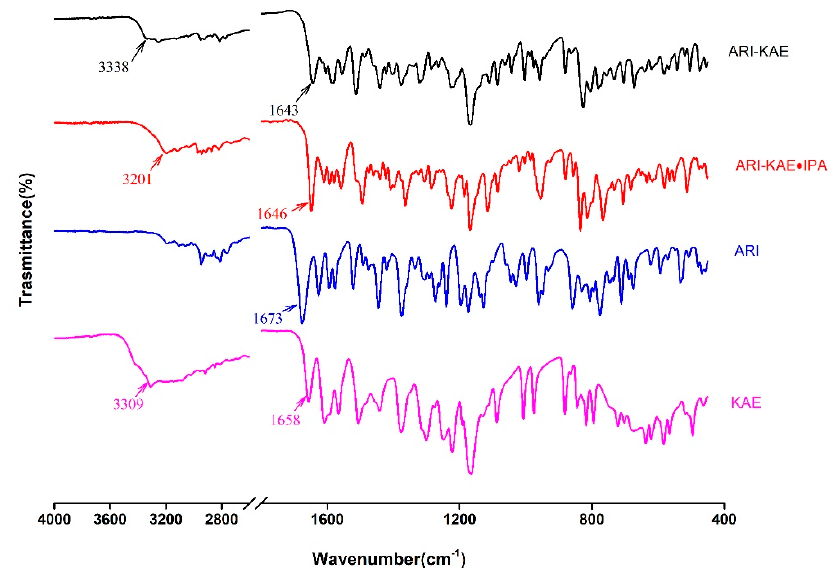
Figure 10. The ATR-FTIR spectrum of ARI, KAE, and their